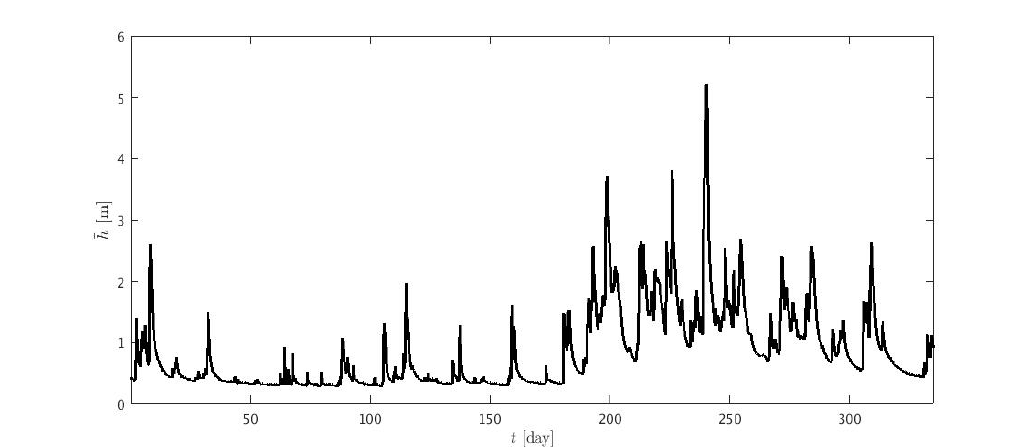
Figure 7. River Aire levels at Armley, Leeds, from May 2015 until the end of March 2016. EA data.